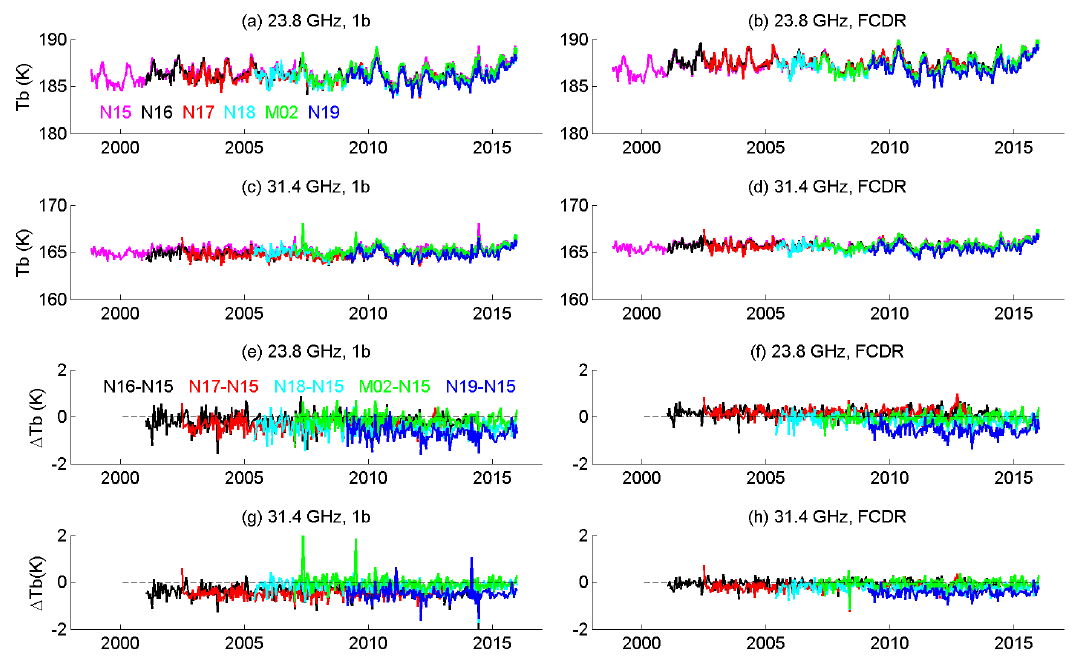
Figure 9. Tropical ocean mean Tb ( a – d ) and ∆ Tb ( e – h ) for 23.8 and 30.4 GHz channels. Left panels display the values of 1b before inter-satellite calibration, while the right panels are FCDRs after inter-satellite calibration.